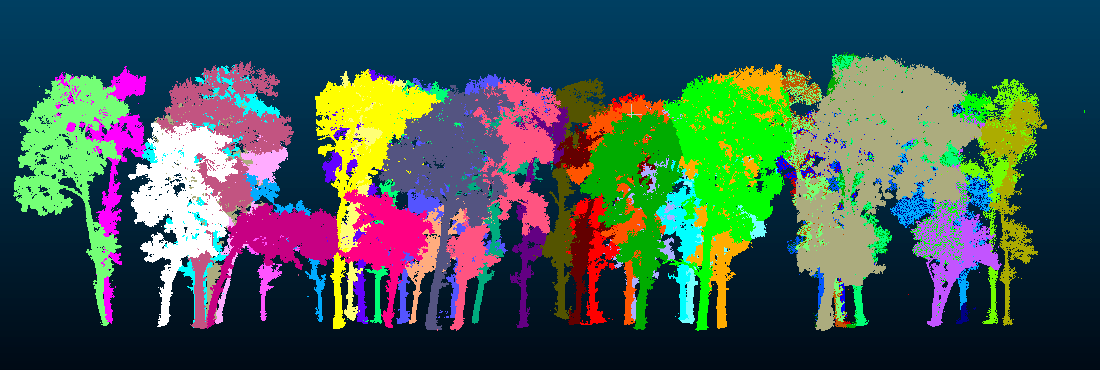
Figure 5. Study area from a terrestrial laser scanning point cloud taken using the FARO Focus 3D X330. These trees were placed back in after the point cloud was divided into single woods. To distinguish the different trees, they are given different colors.